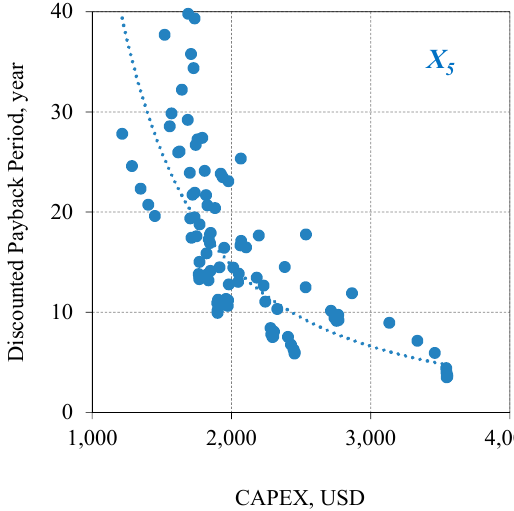
Figure 16. Discounted Payback Period ( Y j ) vs. individual independent parameter ( X i )